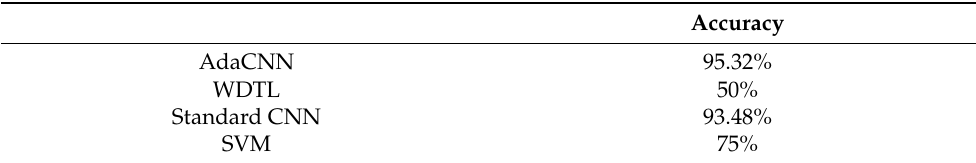
Table 4. The correct rate of fault diagnosis in different positions under the condition of adding 4 db of noise.